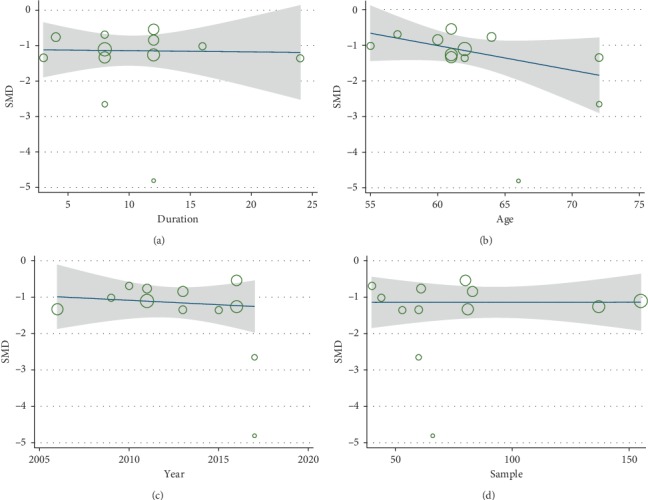
Metaregression of HAMD scale. (a) Treatment duration. (b) Mean age. (c) Publication year. (d) Sample size.